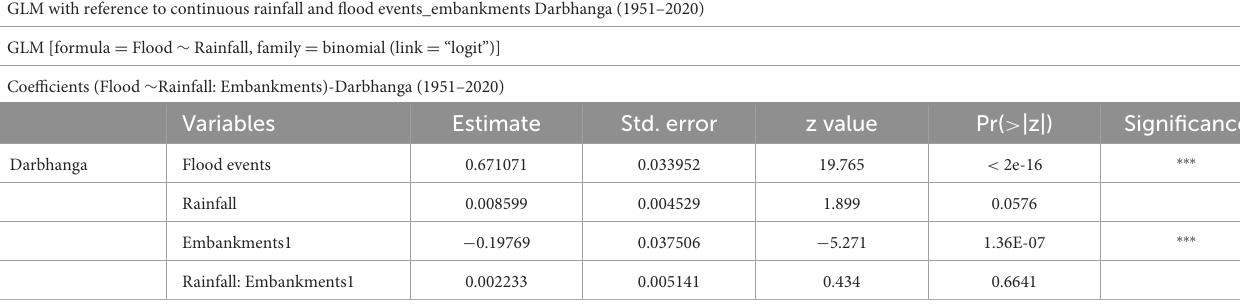
TABLE 3 GLM_rainfall and flood events_embankments (Darbhanga)-1951 to 2020.